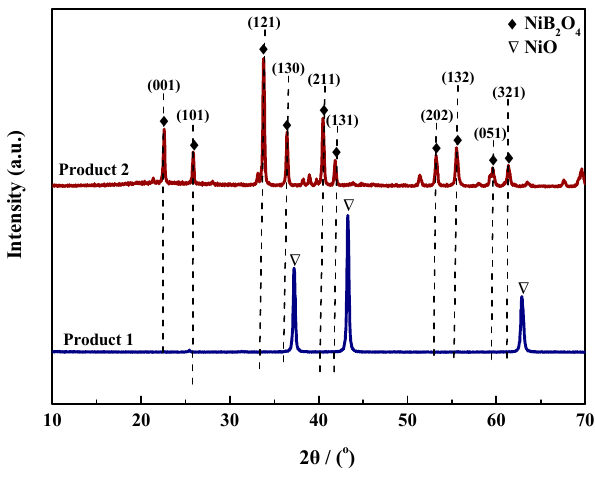
Figure 6. XRD patterns of model reactions